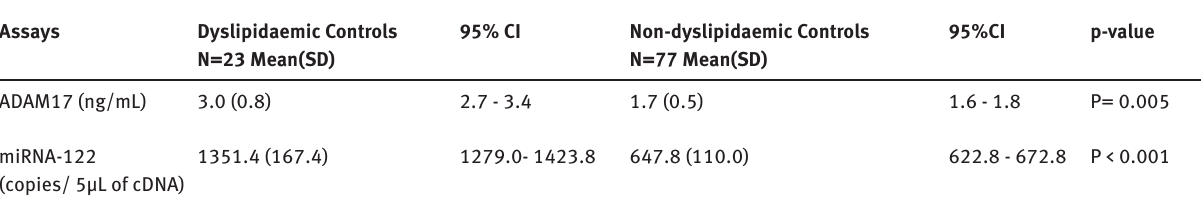
Table 4: Assay Values of Dyslipidaemic and Non-dyslipidaemic Controls. Dyslipidaemic controls were found to have significantly higher values of miRNA-122 and ADAM17 when compared with non-dyslipidaemic controls.